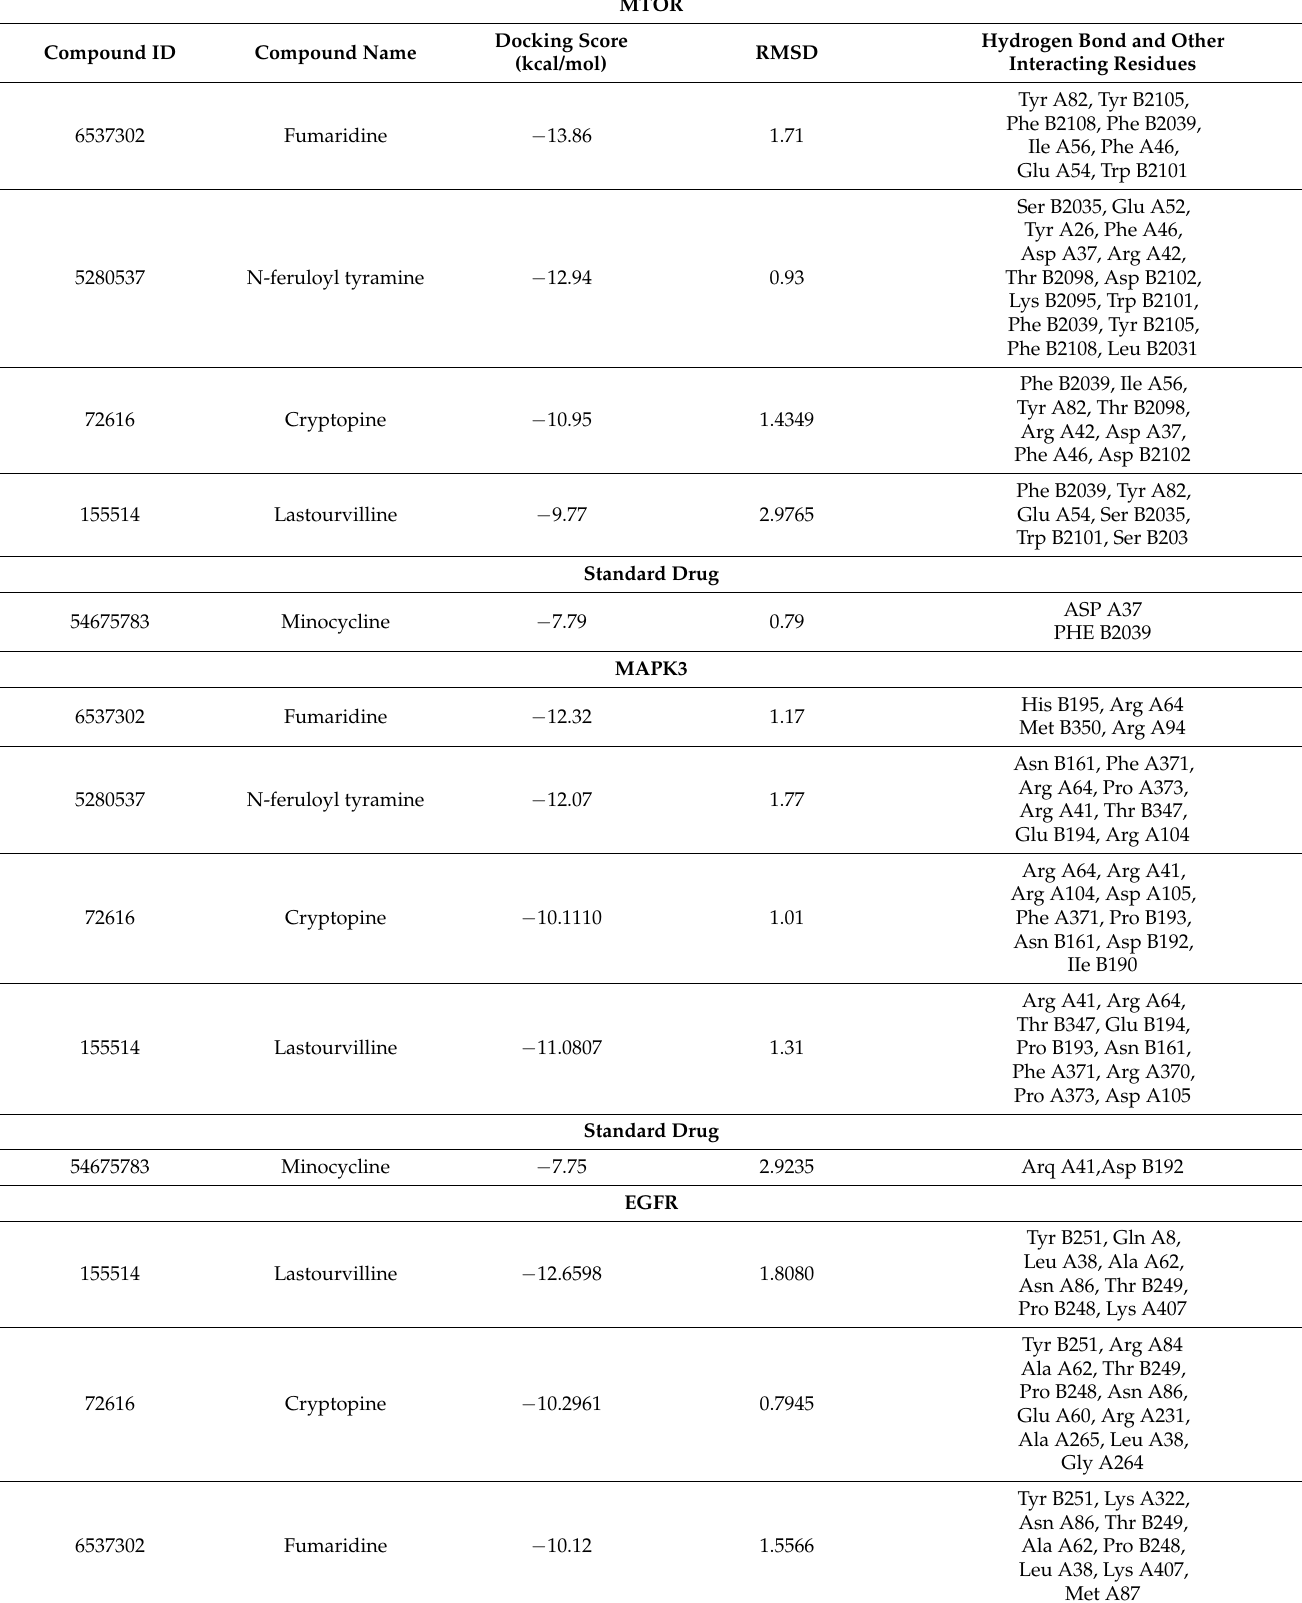
Table 4. Binding energy and interactions of potential active compounds and their four target